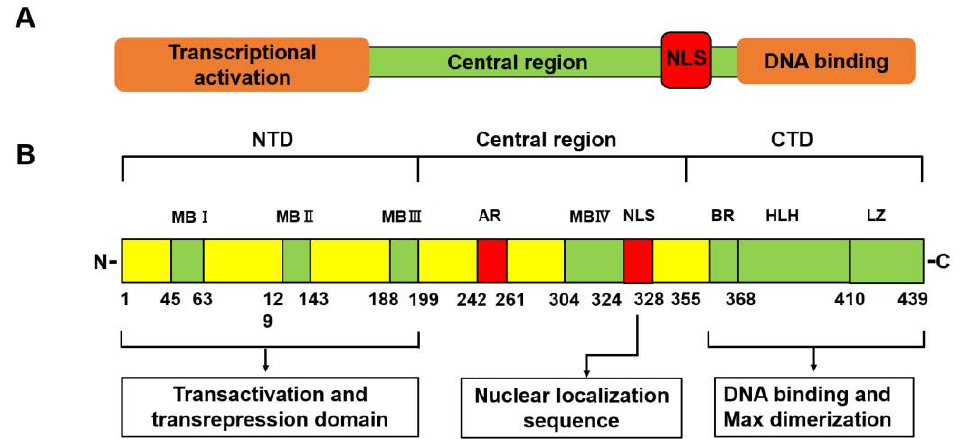
Figure 1. Structures of Myc family proteins ( A ). Mammalian Myc proteins consist of a transcriptional activation domain, a central region, a nuclear localization sequence (NLS), and an area involved in DNA binding. Structures of human c-Myc protein ( B ). The N-terminal transactivation domain (NTD) includes three conserved regions named as Myc box-I, II, and III (MBI, MBII, and MBIII) and the acidic region (AR). MBI and MBII are necessary for Myc transcriptional and cell-transforming activity as well as recruitment of Myc transactivation. MBIII regulates transcriptional suppression. In the central region, MBIV is involved in apoptosis, transformation and modulation of DNA-binding. The C-terminal domain (CTD) includes the basic, the helix-loop-helix, and the leucine zipper domains (b-HLH-LZ) and is necessary for dimerization with Myc associated protein X